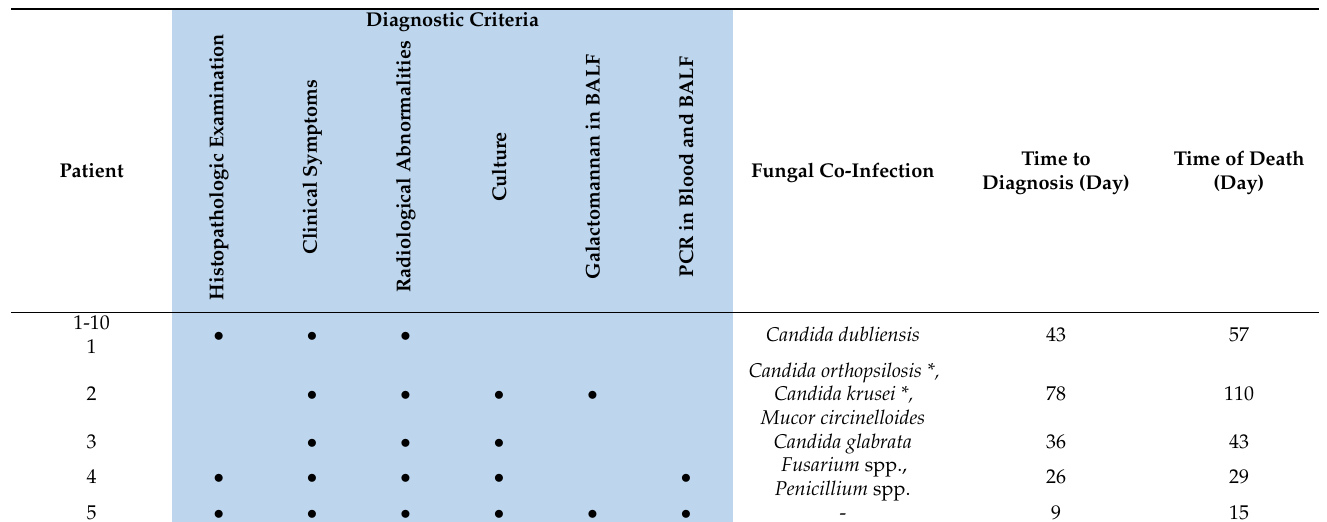
Table 7. Description of patients with invasive